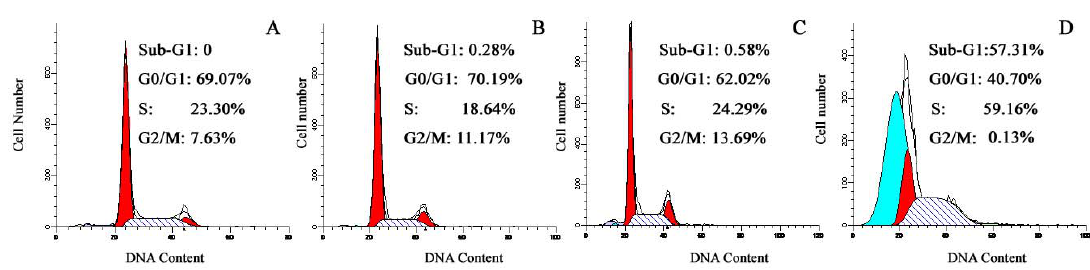
Figure 6. Effect of T α PcZn-PDT on the cycle and apoptosis of Bel-7402 cells assayed by flow cytometry analysis of DNA content. Assay of cycle and apoptosis in: panel A , control Bel-7402 cells treated with 0.1% DMSO; panel B , Bel-7402 cells treated with red-light irradiation (53.7 J/cm 2 ); panel C , Bel-7402 cells treated with 54 μ M T α PcZn; and panel D , Bel-7402 cells treated with 54 μ M T α PcZn in the presence of red-light irradiation (53.7 J/cm 2